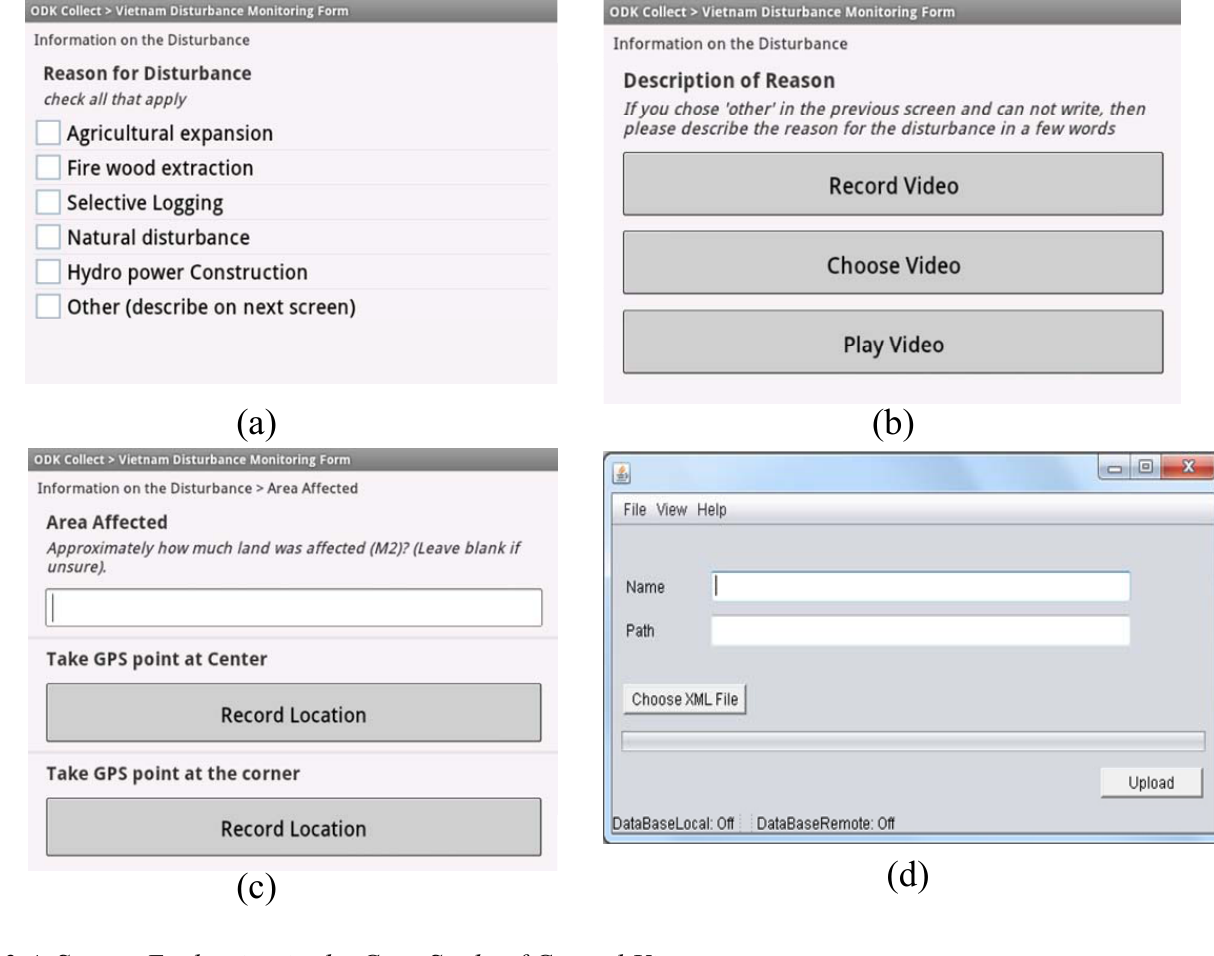
Figure 3. Some screenshots of deployed application interface to: ( a ) select the reason for forest disturbance; ( b ) record video as forest disturbance description; ( c ) record area for forest disturbance and ( d ) upload form to the database